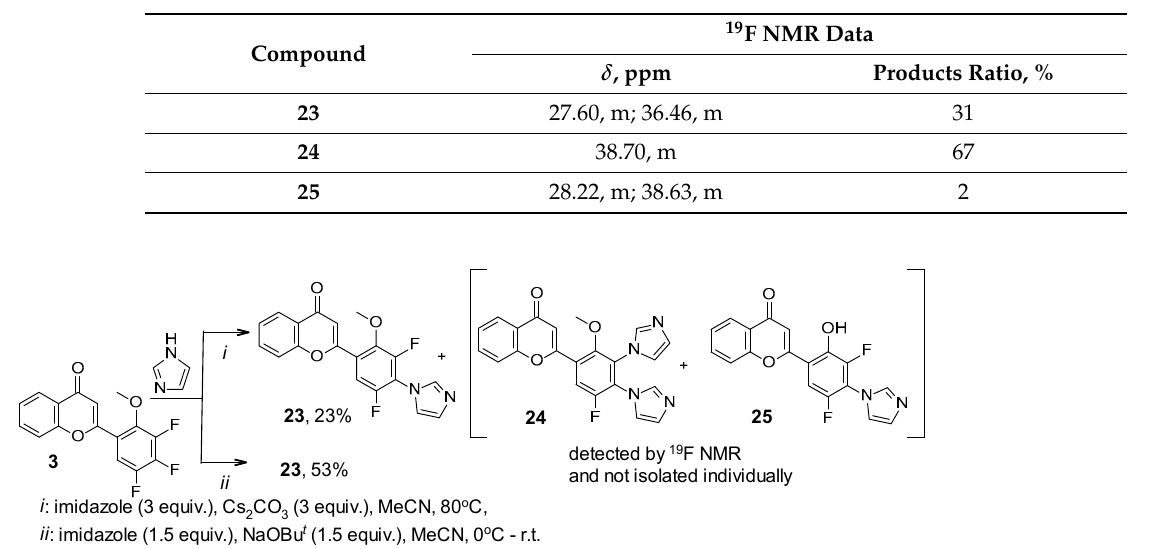
Table 5. 19 F NMR data of mixture of Cs 2 CO 3 -promoted reaction of flavone 3 and imidazole. Compound